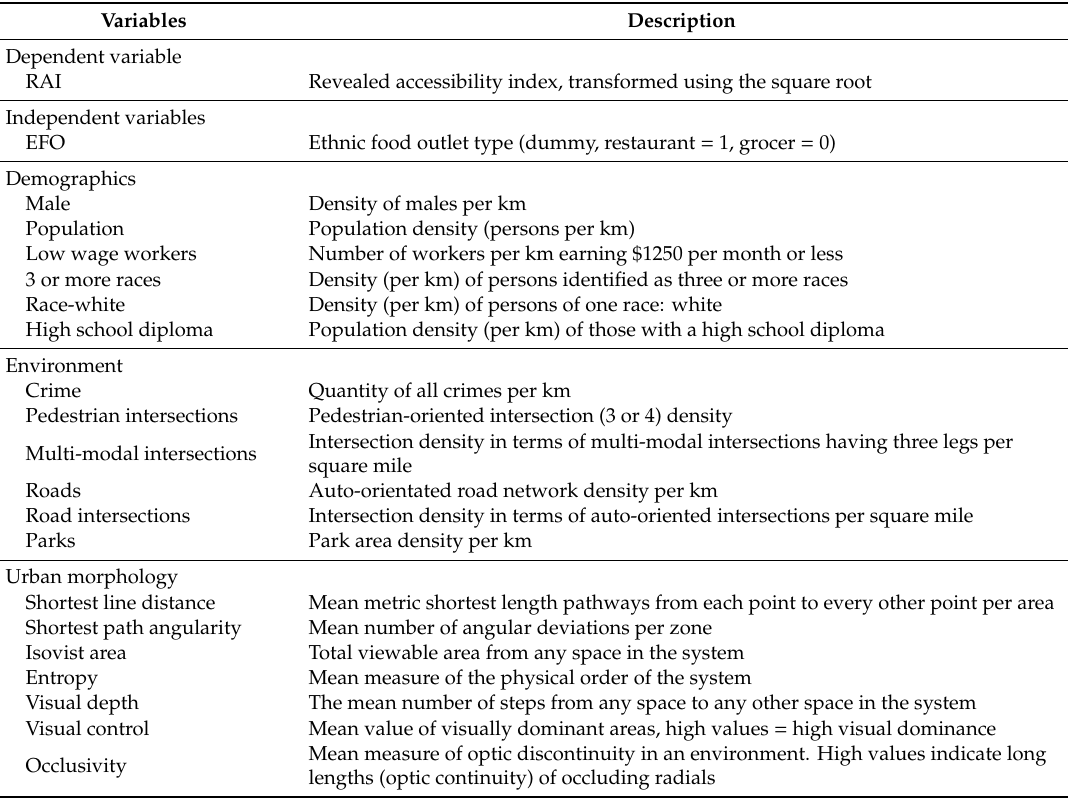
Table 3. Variable